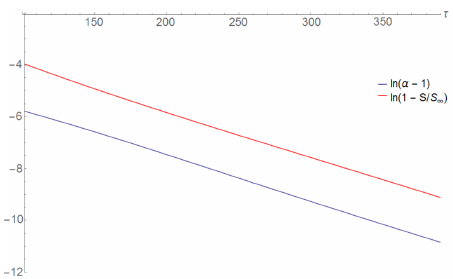
Figure 8. Linearized evolution of the normalized entropy and anisotropy